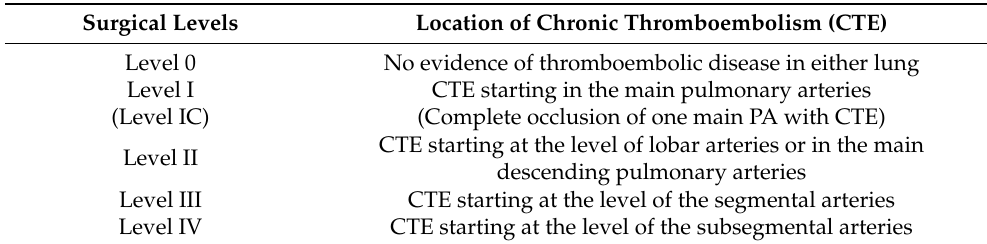
Table 4. PA occlusion morphology (University of California San Diego chronic thromboembolism surgical